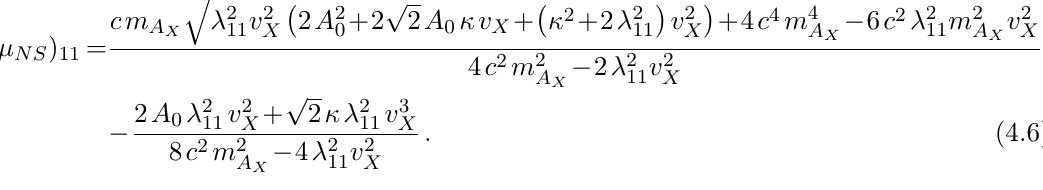
10 (cid:0) 3 from the (cid:2)